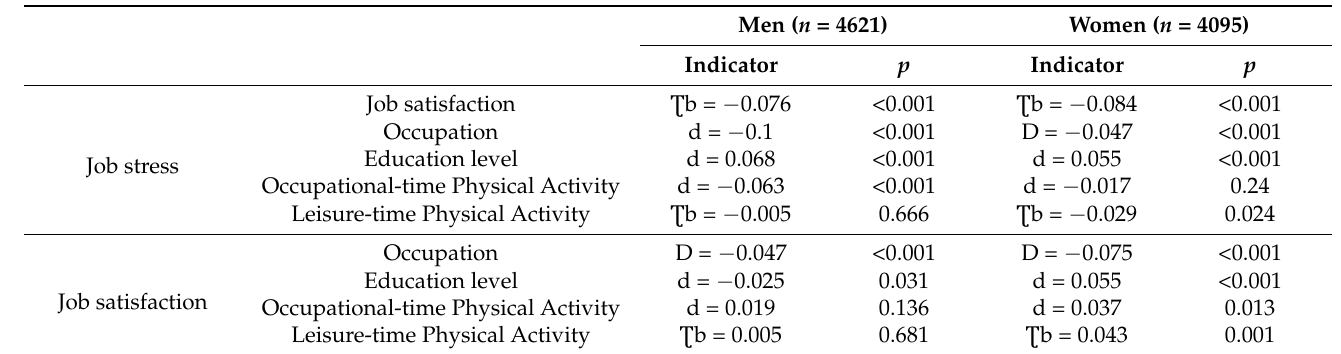
Table 2. Univariate analysis according to sex ( n = 8716).